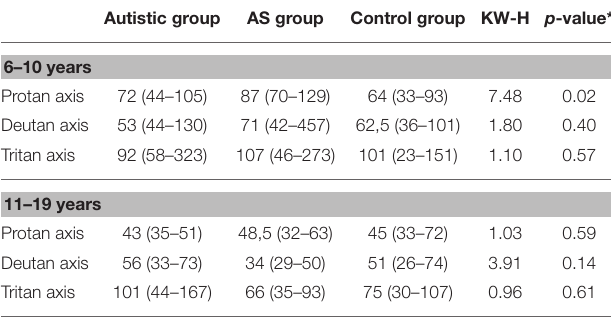
TABLE 4 | Comparison of color vision threshold medians among the age groups. Autistic group AS group Control group KW-H p -value*